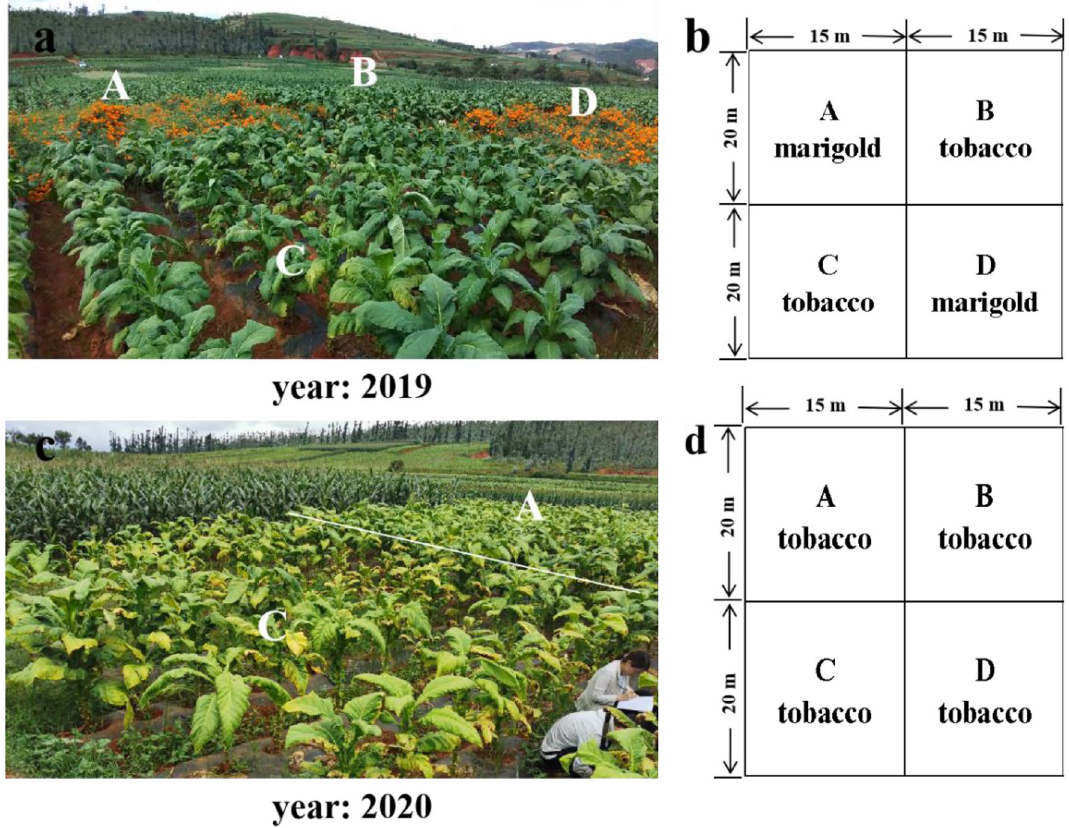
test design of marigold-tobacco rotation in